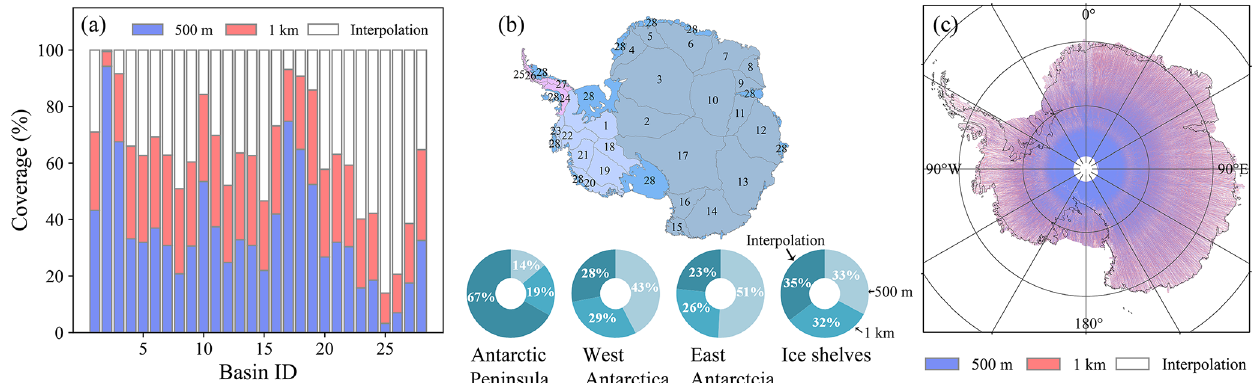
Figure 8. (a) Coverage of observed grid cells at 500m and 1km and interpolated grid cells in 27 drainage basins of ice sheets (Zwally et al., 2012) and ice shelves. The boundaries and basin index (ID) of 27 ice sheet drainage basins (numbers 1–27) and ice shelves (number 28) are shown in (b) . The coverages of observed (at two spatial resolutions) and interpolated grid cells in the Antarctic Peninsula, West Antarctica, East Antarctica and ice shelves are also shown in (b) . Map of the selected grid cell resolution for deriving the ICESat-2 DEM in all grid cells at a spatial resolution of 500m (c) . Elevation values derived from 1km and interpolation (i.e. 1km) are resampled to a resolution of 500m. Table 4. Comparisons between the ICESat-2 DEM and OIB airborne elevation measurements (including data in areas of low elevation change from 2009 to 2017 and data in the Antarctica from 2018 to 2019) in observed and interpolated areas for individual regions (i.e. the ice sheet and ice shelves). MeD: median deviation, MeAD: median absolute deviation, SD: standard deviation, RMSD: root-mean-square deviation. Region MeD MeAD SD RMSD Number of used (m) (m) (m) (m) OIB measurement points